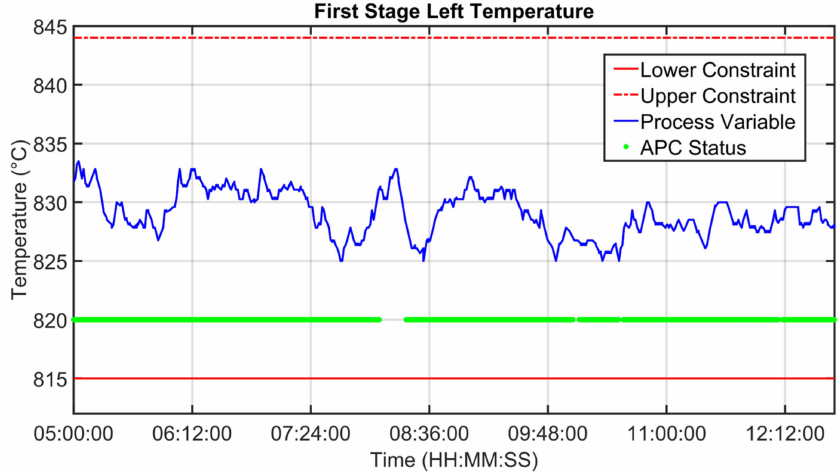
Figure 21. Rotary kiln APC system: field results (first-stage left temperature CV).